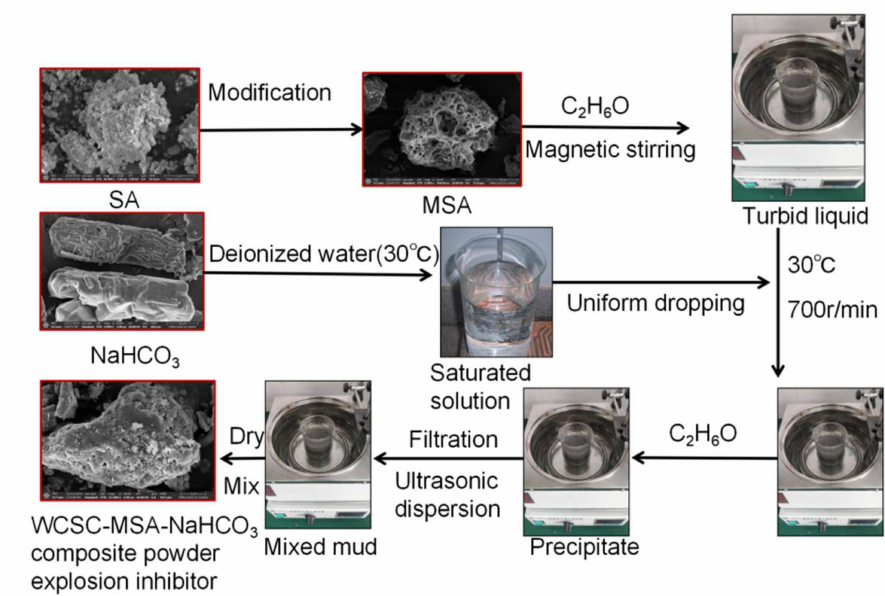
Figure 1. The WCSC compounding